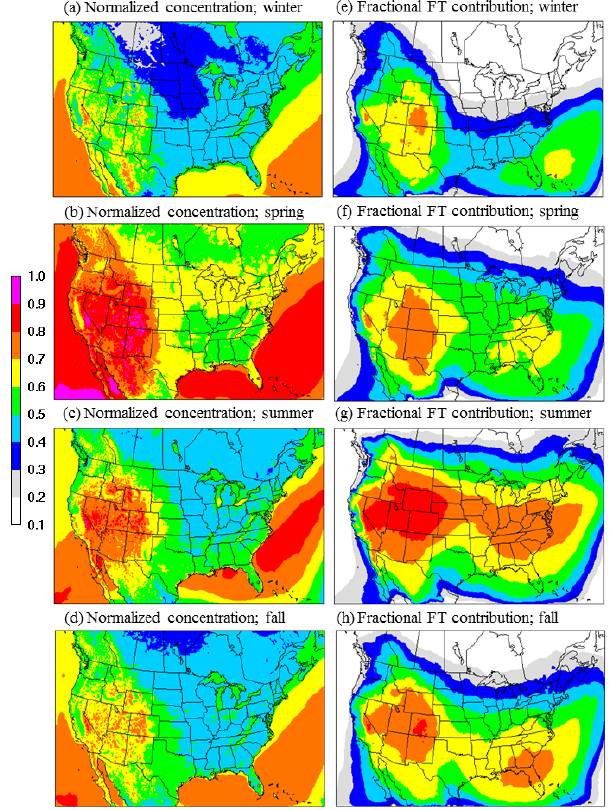
Figure 1. Impact of lateral boundary conditions (LBCs) on simu- lated seasonal surface-level concentrations. (a–d) Spatial variation in seasonal-mean surface concentrations normalized by the maxi- mum value within the model domain across all seasons. (e–h) Frac- tional contribution of free-tropospheric (FT) LBCs (specified be- tween 750 and 250hPa) to the total LBC-derived concentrations at the surface. Seasons are defined as winter (December–February), spring (March–May), summer (June–August), and fall (September–